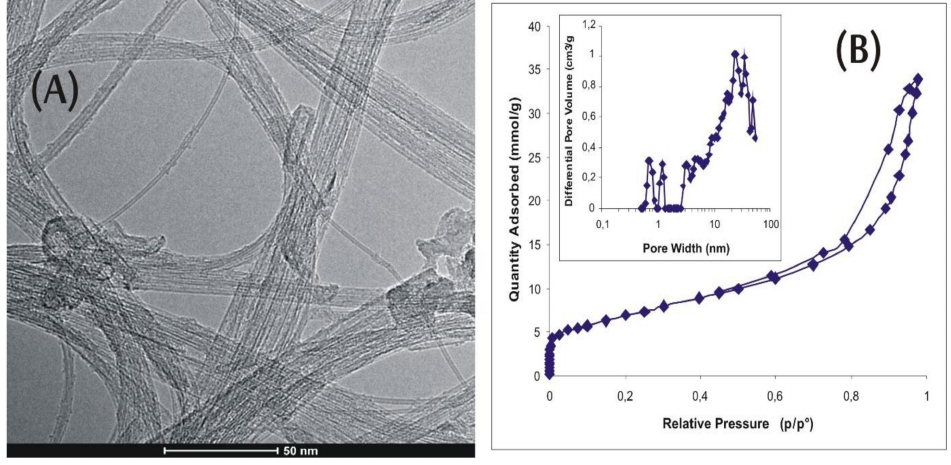
Figure 2. Morphology of single-walled-carbon-nanotube (SWCNT) sample: ( A ) HRTEM image; ( B ) low-temperature (77 K) N 2 adsorption